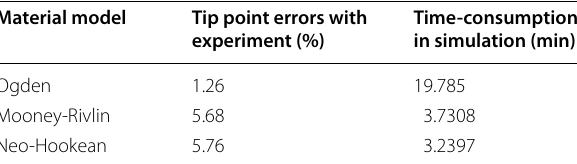
Table 1 Tip point errors with experiment and time- consumption of different material models